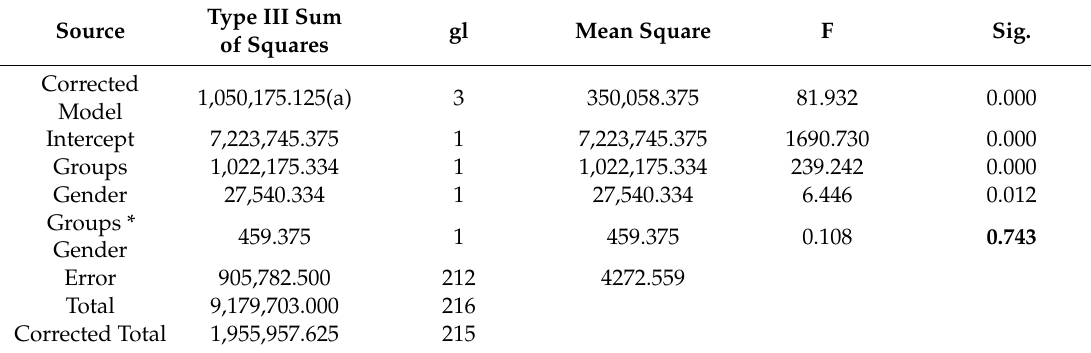
Table 6. Two-way ANOVA: Time taken to play chord transitions (short